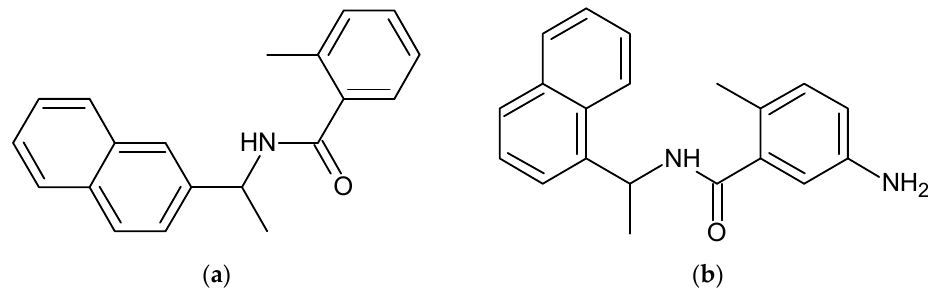
Figure 1. Structures of compound 7724772 ( a ) IUPAC name 2-methyl- N -[1-(naphthalen-2-yl) ethyl] benzamide and its optimized derivative GRL-0617 ( b ) with an IUPAC name 5-amino-2-methyl- N -[1- (naphthalen-1-yl) ethyl]